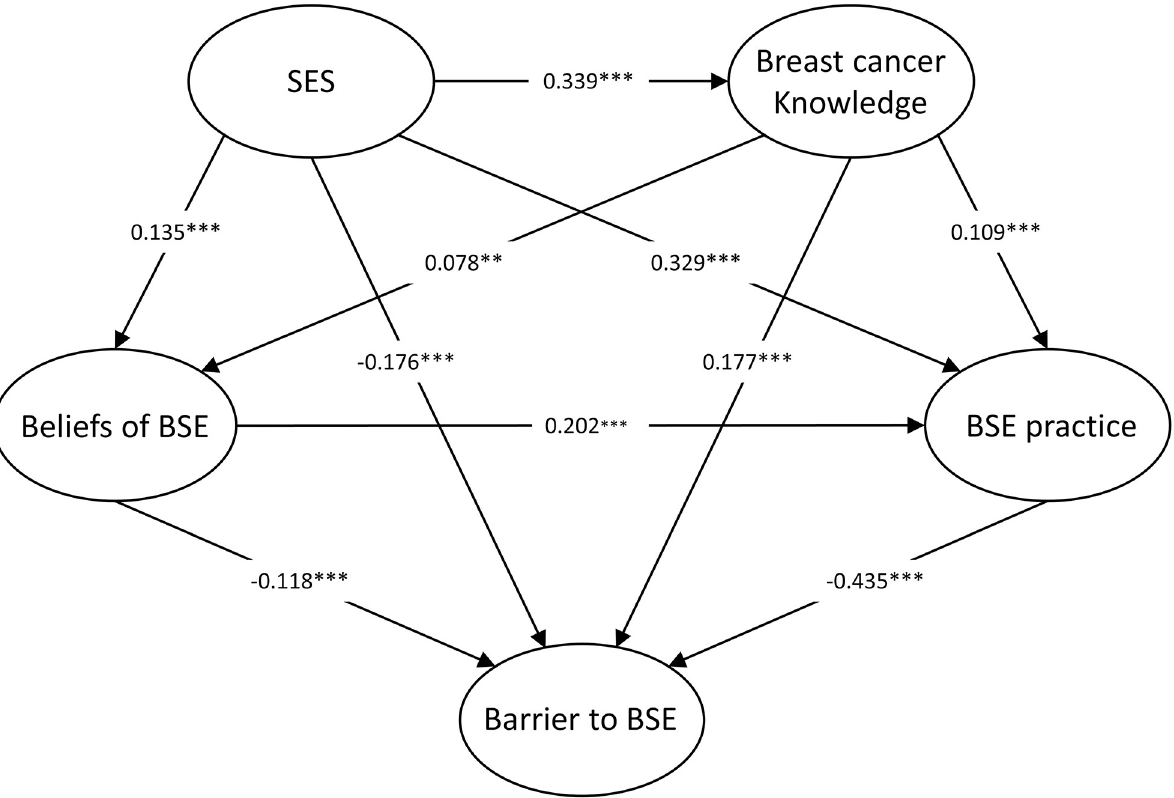
Fig 2. The final model (M2) with standardized path coefficients. ��� p < 0.001; �� p < 0.01; � p < 0.05. SES, Socioeconomic Status; BSE, breast self-